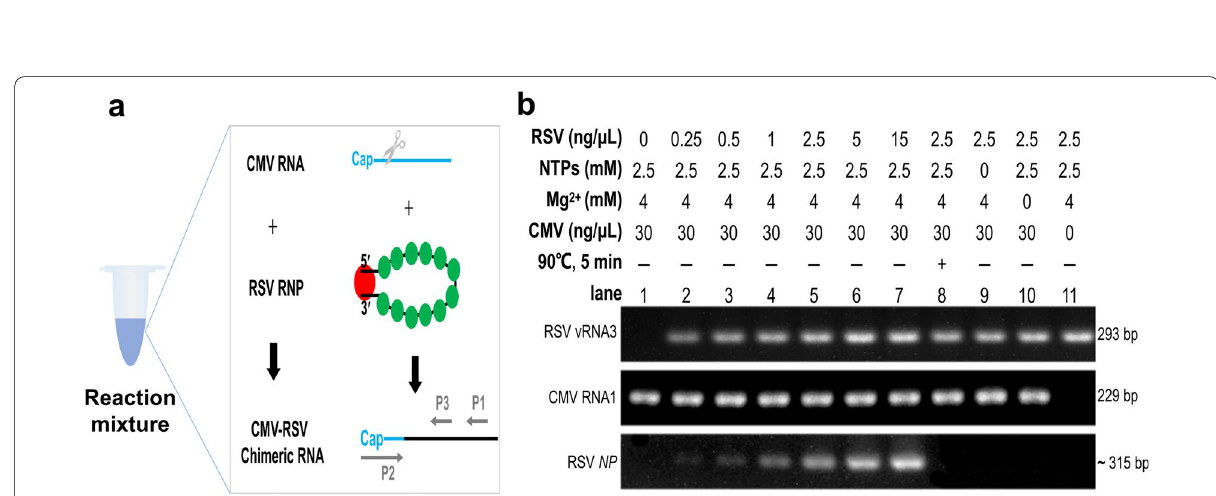
Fig. 2 RSV performs transcription in vitro. a A diagram illustrating the strategy to detect in vitro transcripts (the NP mRNA). CMV RNAs (the blue line, only one of the CMV RNA segments was shown here) and RSV RNPs are present in the reaction mixture. The RdRp (red ball) of RSV RNPs (only one RNP is shown here) cleaves CMV RNAs, obtaining a CRL (not shown). The CRL is used as a primer to transcribe viral template RNAs, leading to the generation of chimeric RSV mRNAs with a CMV-derived CRL at their 5 ʹ ends, which can be detected by nested RT-PCR using primers 1, 2 and 3 (P1–P3). Primer 2 is a composite primer with ten nucleotides at its 3 ʹ -end identical to the 5 ʹ terminus of CMV RNA1. Similar nested RT-PCR was conducted to detect RSV and CMV genomic RNAs. In doing this, all the three primers anneal to the coding region of RSV NP (not shown) or CMV RNA1. b Gel electrophoresis of the RT-PCR product. The RT-PCR product from each reaction mixture as indicated on top of the gel was electrophoresed in a 1.5% agarose gel before being